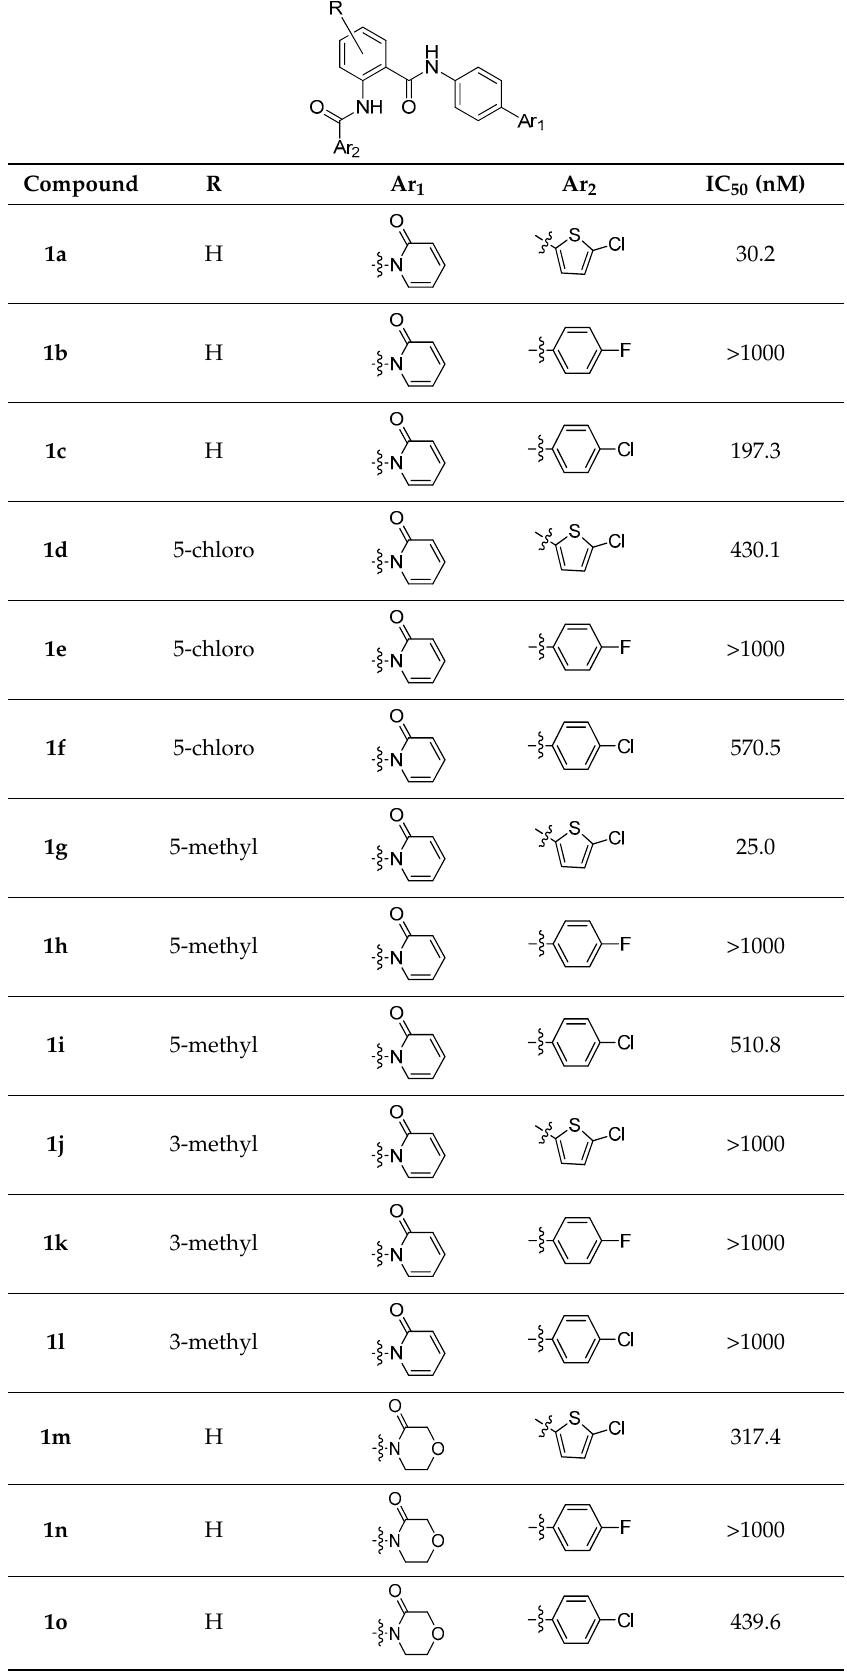
Table 1. The structures of the target compounds 1a – 1x and their biological activity evaluation.